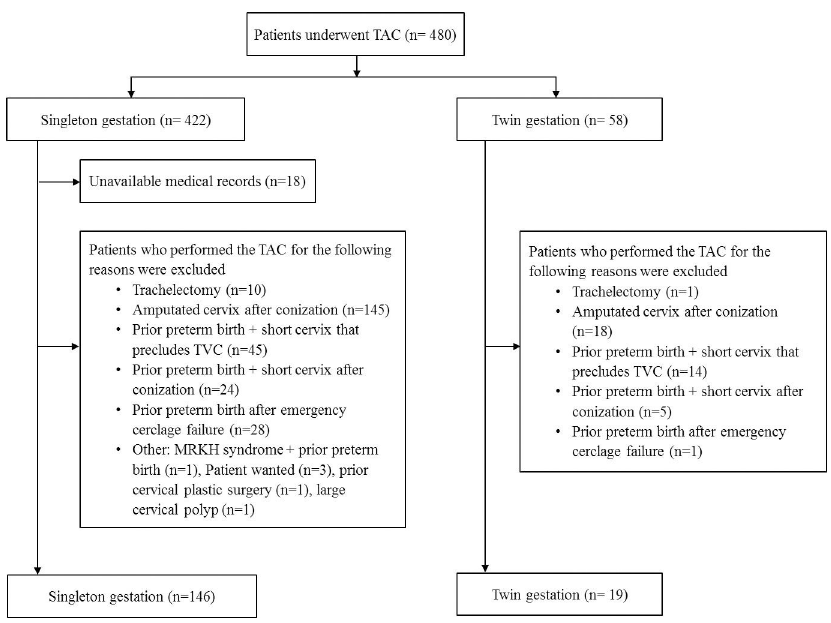
Fig 1. Detailed reasons of exclusion and number of patients who underwent transabdominal cerclage. TAC, transabdominal cerclage; TVC, transvaginal cerclage; MRKH, Mayer-Rokitansky-Ku¨ster-Hauser.